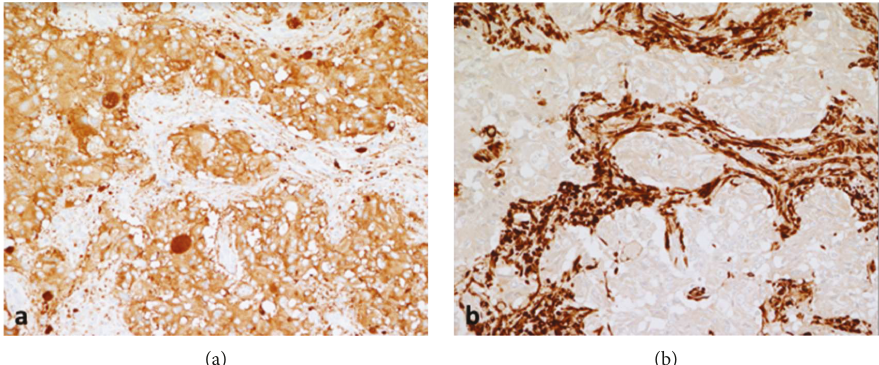
Figure 4: Pathology slides stained with immunohistochemistry. Synaptophysin stain, shown in (a), demonstrates epithelioid-type cells. Spindle cells stain positive for S100 in